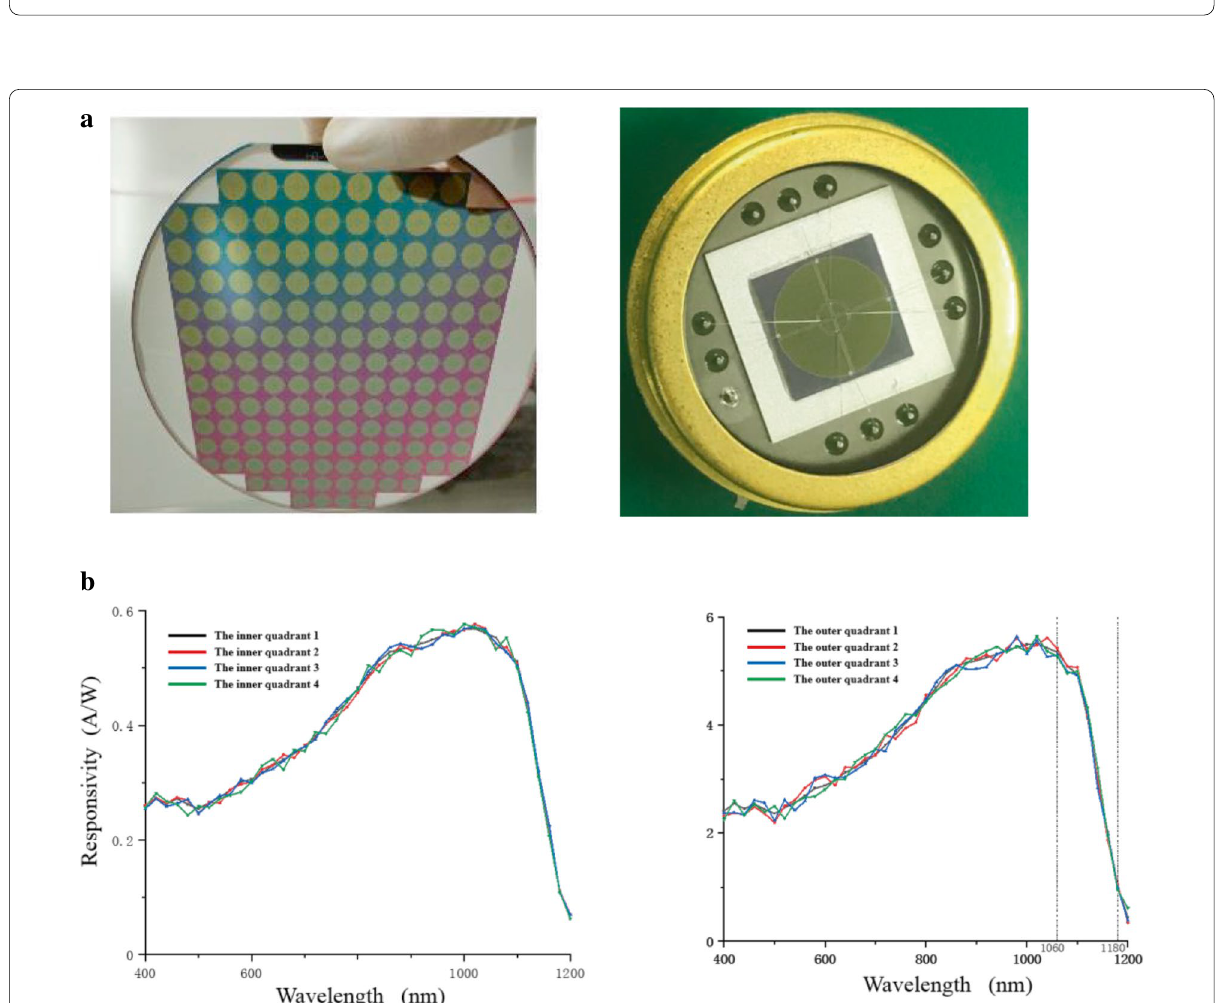
Fig. 11 a The physical picture of dual four-quadrant photodetector. b The responsivity of different dual four-quadrant photodetector